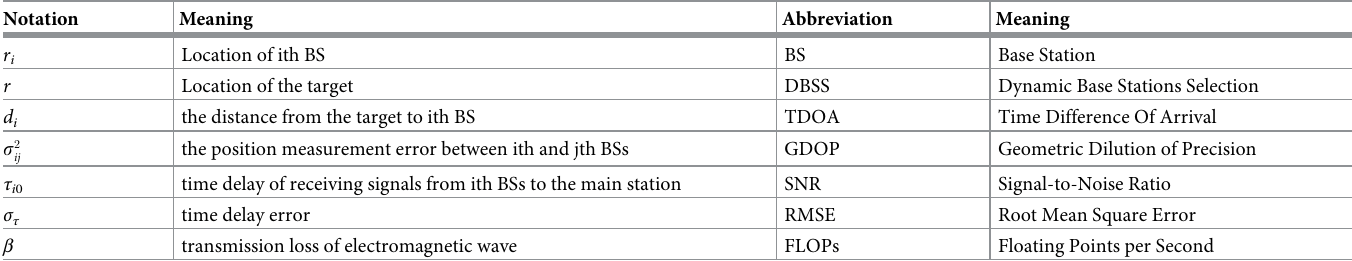
proposed algorithm has the same performance as the exhaustive method in cellular network, and has less floating-point computation, which is more suitable for real-time target monitoring.